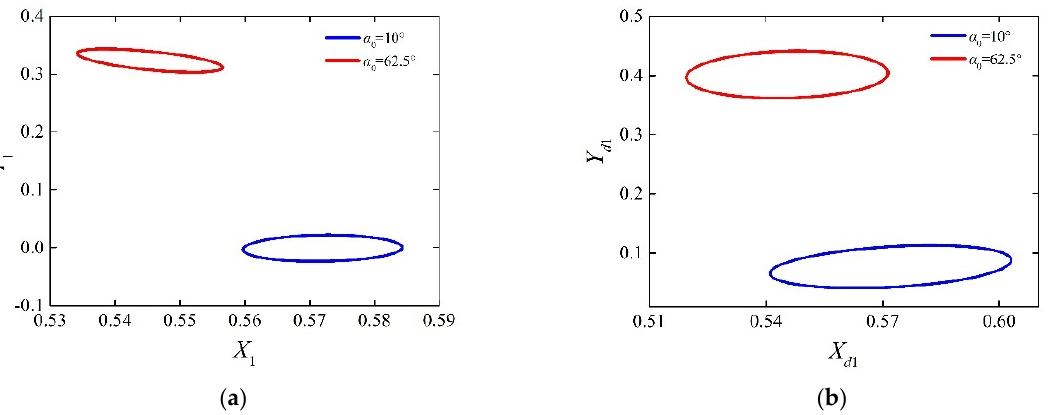
Figure 9. Quasiperiodic motion of the rod – fastened rotor at ω = 2500 rad/s: ( a ) orbit and Poincaré map at the left bearing station; ( b ) orbit and Poincaré map at the left disk station; ( c ) comparison of spectrogram at the left disk and left bearing stations; ( d ) comparison of the time series diagram at the left disk and left bearing stations.